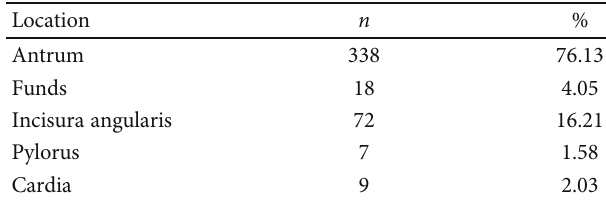
Table 6: LGIN lesion